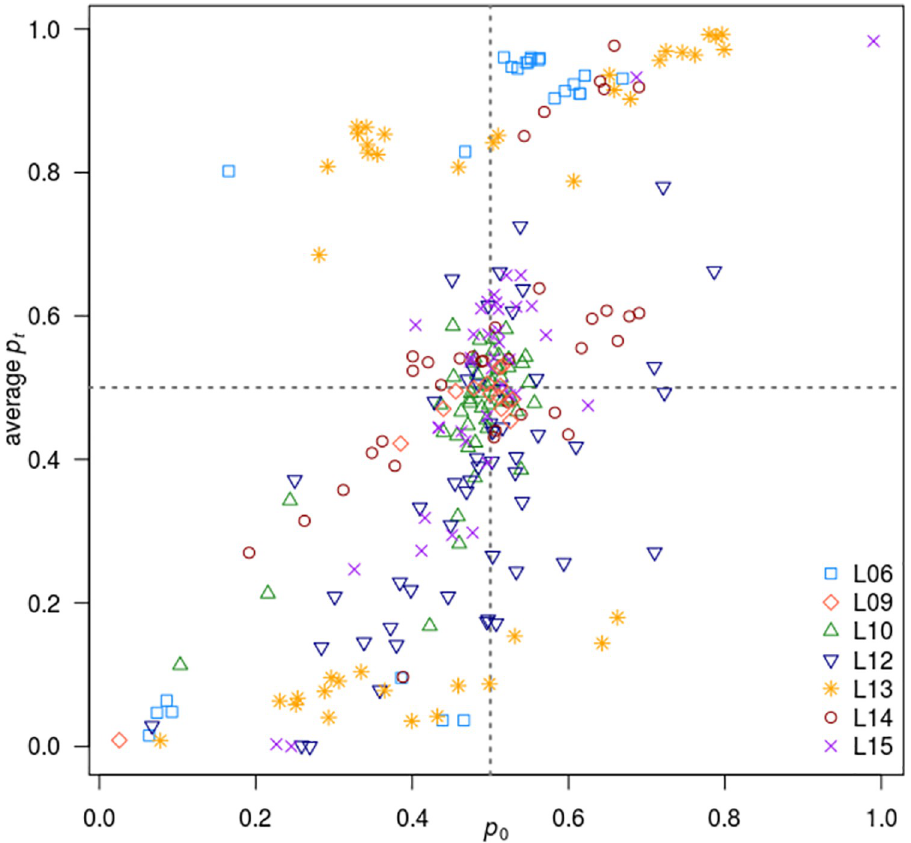
Fig 3. Mutation frequencies at the start of experimental evolution ( p 0 ) versus average mutation frequencies at the end of experimental evolution ( p t ). The different recombinant populations are indicated with different colours and symbols. The dotted lines represent the frequencies of